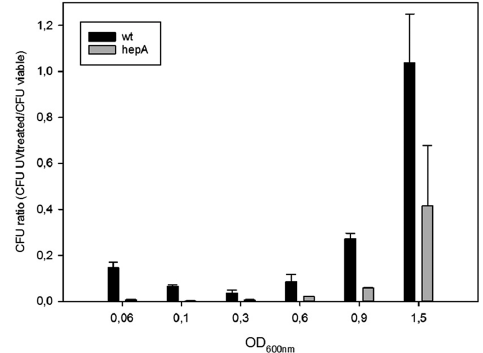
Figure 5. Sensitivity of hepA mutants to UV. Figure shows the ratios between viable cells of UV treated and untreated cells at different cell densities (OD 600 ) along the growth curves of T. thermophilus HB27 gdh:.kat (wt) and T. thermophilus HB27 Δ hepA::kat mutant.